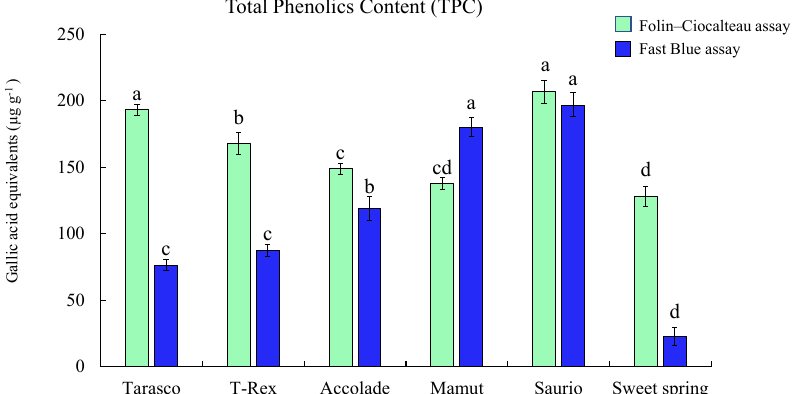
(GAE) for each solvent, different letters indicate significant differences ( p ≤ 0.05) among the solvent combinations.